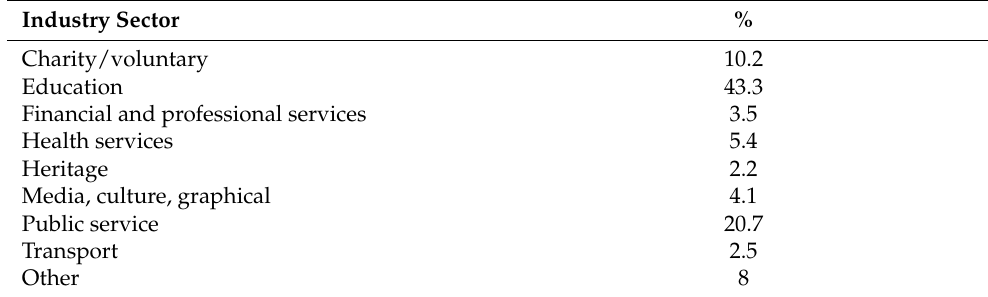
Table 3. Industry sector (n = 314).